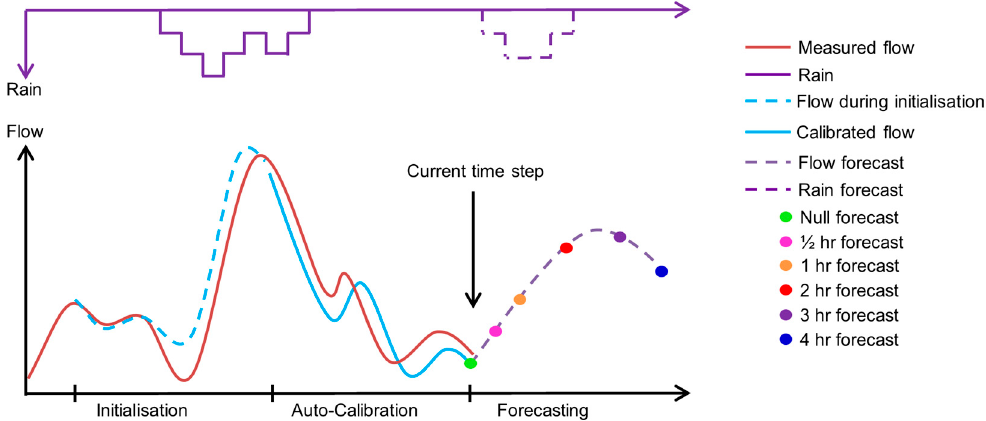
Figure 1. Illustration of the three steps that constitute the applied flow forecasting procedure; modelled flow is shown for the initialisation, the auto ‐ calibration and the forecasting steps.